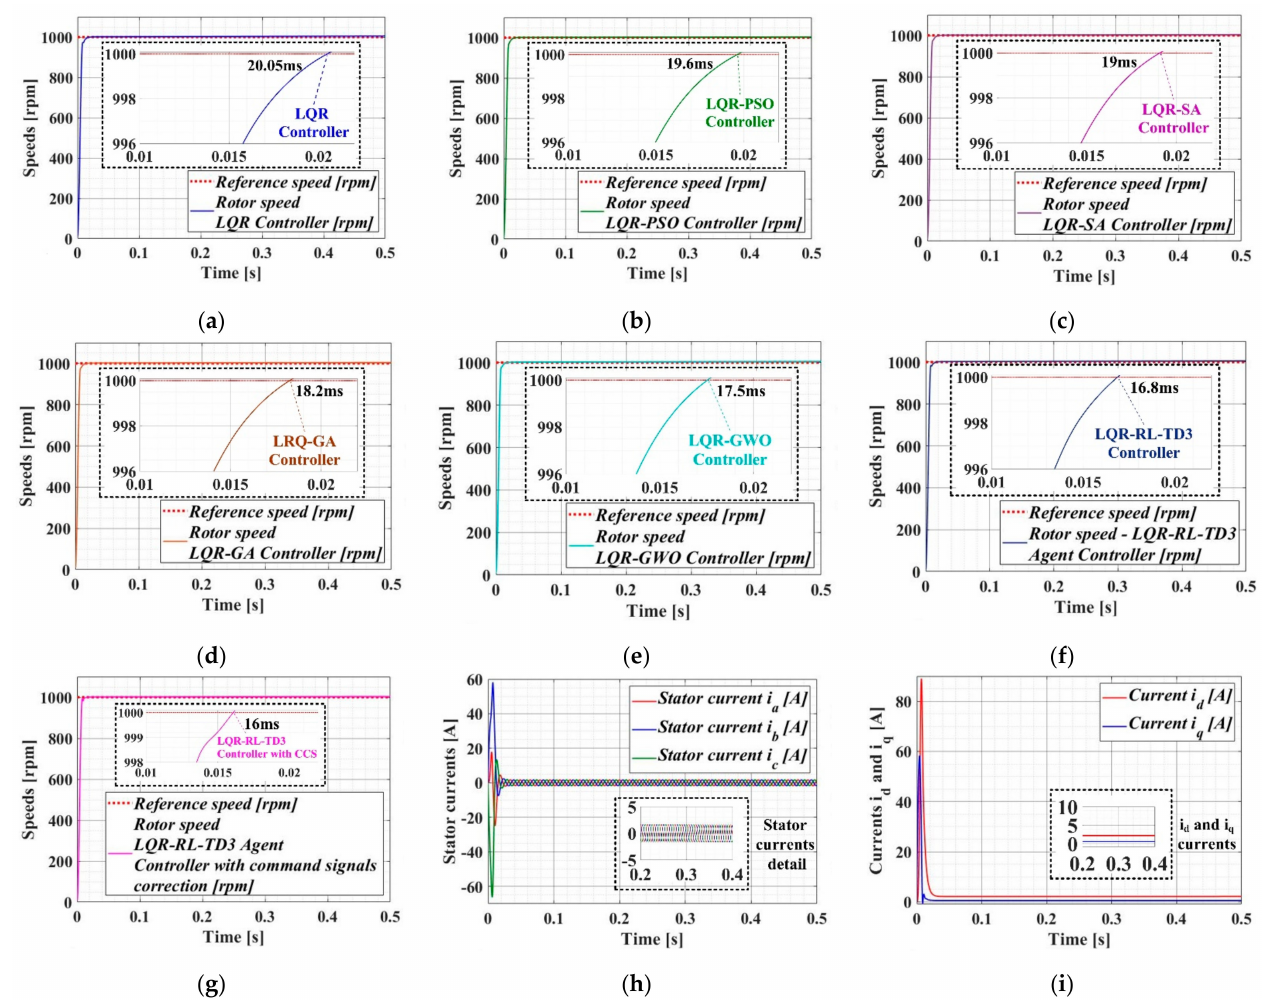
Figure 12. Time evolution parameters of the PMSM–CS–CI based on the LQR-type controller: ( a ) rotor